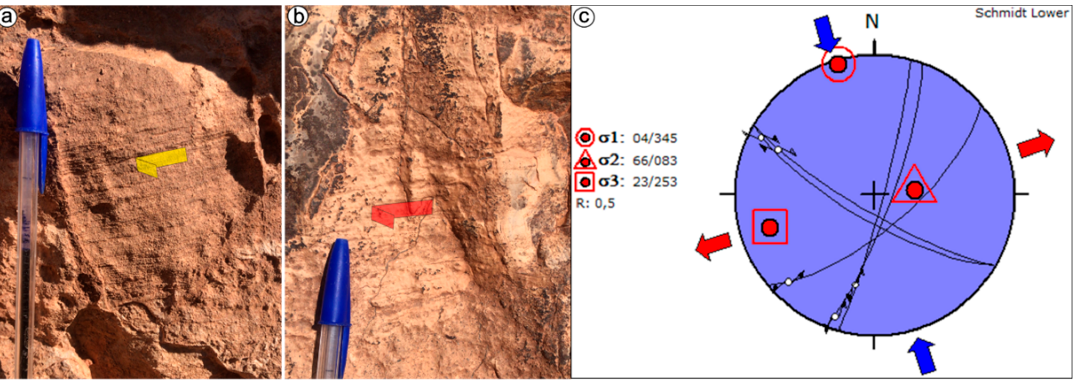
Figure 11. ( a , b ) Photographs of strike-slip faults affecting Cenomano-Turonian limestones north of Imiter mine; ( c ) stereogram and stress axes orientation during the Atlasic compression.